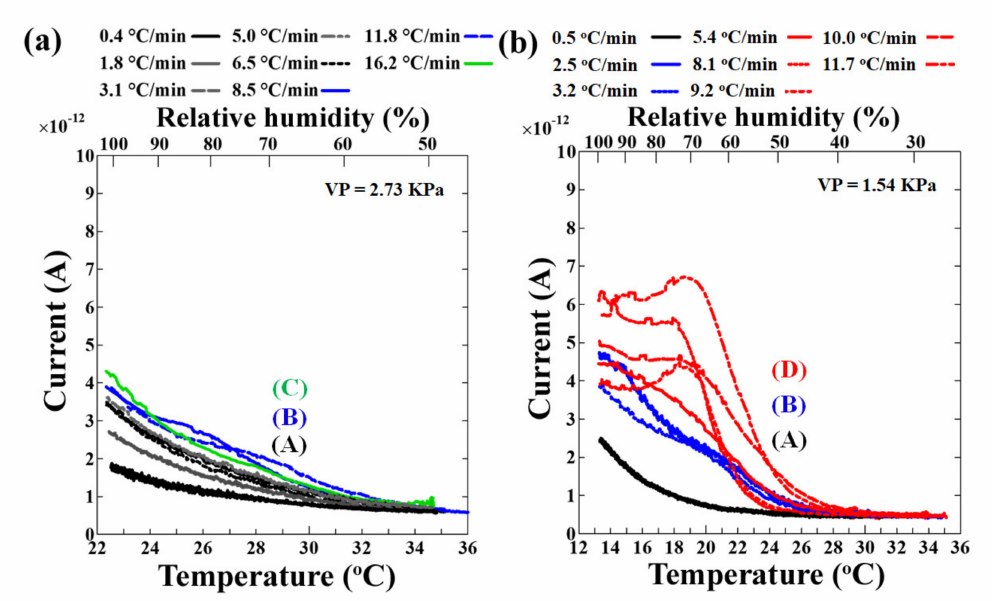
Figure 5. Output response (current) as a function of the temperature of the sensor’s surface being cooled at di ff erent cooling rates from 35 ◦ C at ( a ) 2.73 kPa and ( b ) 1.54 kPa vapor pressure (VP). The output has been shown till 100% relative humidity in each case. The types of current increasing trends observed at 2.73 kPa and 1.54 kPa vapor pressure have been assigned ( A ) for black lines, ( B ) for blue lines, ( C ) for green line, and ( D ) for red